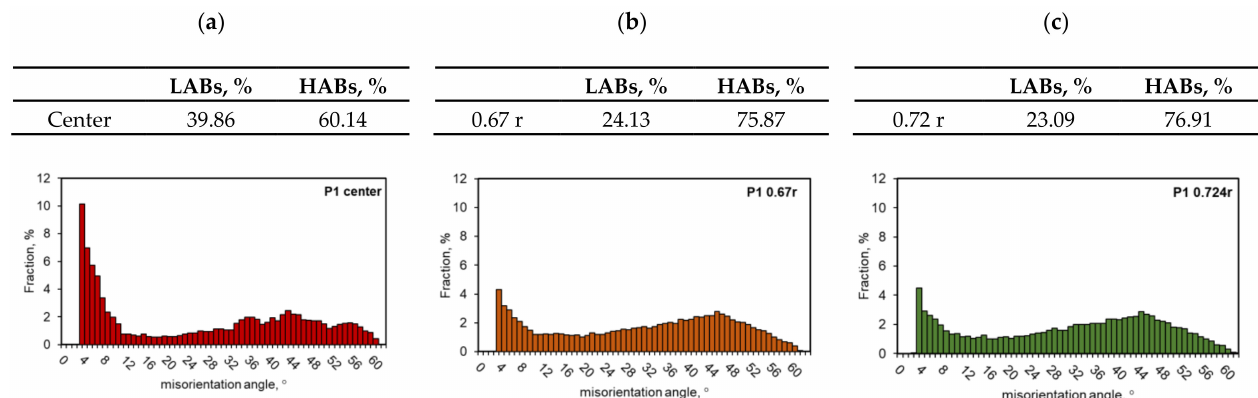
Figure 24. EBSD analysis results of the sample after deformation: ( a,b,c ) centre of the sample, ( d,e,f ) distance from the centre = 0.67 r, ( g,h,i ) distance of the centre = 0.72 r; ( a,d,g ) EBSD maps showing changes in orientation, ( b,e,h ) maps showing the types of edges (the edges of a large angle are marked in black, and the edges of a small angle are marked in blue) and a ( c,f,i ) basic triangle—orientation intensity.